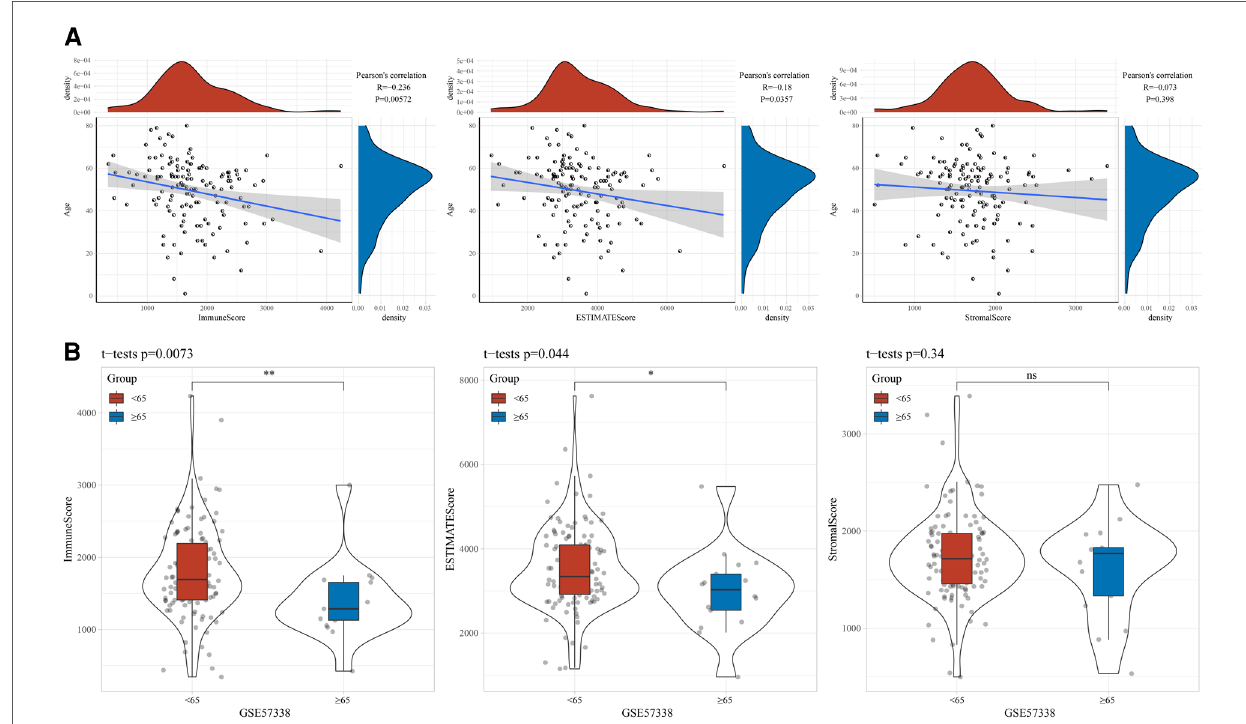
FIGURE 1 Correlation between age and immunity. ( A ) Correlation between age and stromalScore, immuneScore, ESTIMATEScore. ( B ) Differences in the distribution of stromalScore, immuneScore and ESTIMATEScore between age